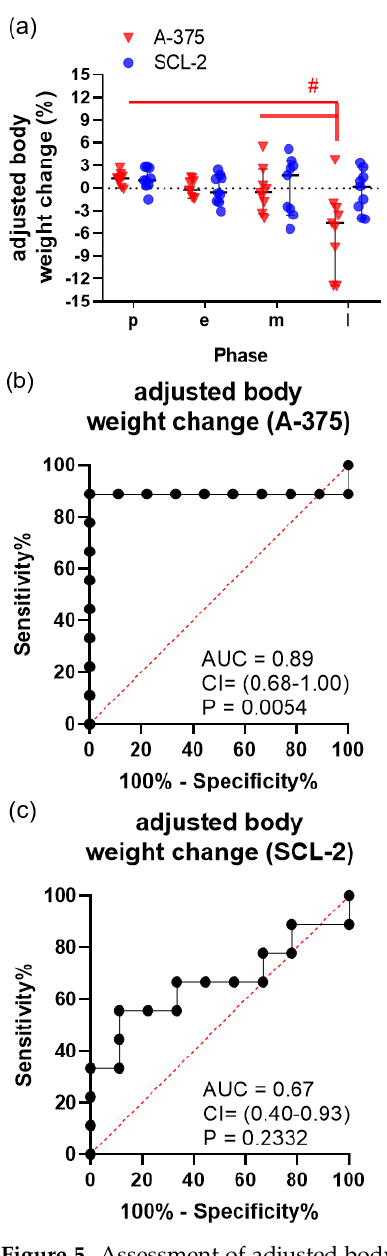
Figure 5. Assessment of adjusted body weight after subtracting the tumor weight from the body weight. ( a ) Percentage of adjusted body weight change of mice during the growth of A-375 and SCL-2 tumors during the pre (p), acute (a), early (e), middle (m) and late (l) phase. Diagnostic ability of adjusted body weight between tumor-free mice and mice with A-375 ( b ) or SCL-2 ( c ) tumors in the late phase. The area under the curve (AUC), the 95% confidence interval (CI) and the p -value (P) for testing the AUC to be 0.5 are presented in each graph. # p ≤ 0.0315; A-375: n = 9, SCL-2: n = 9.